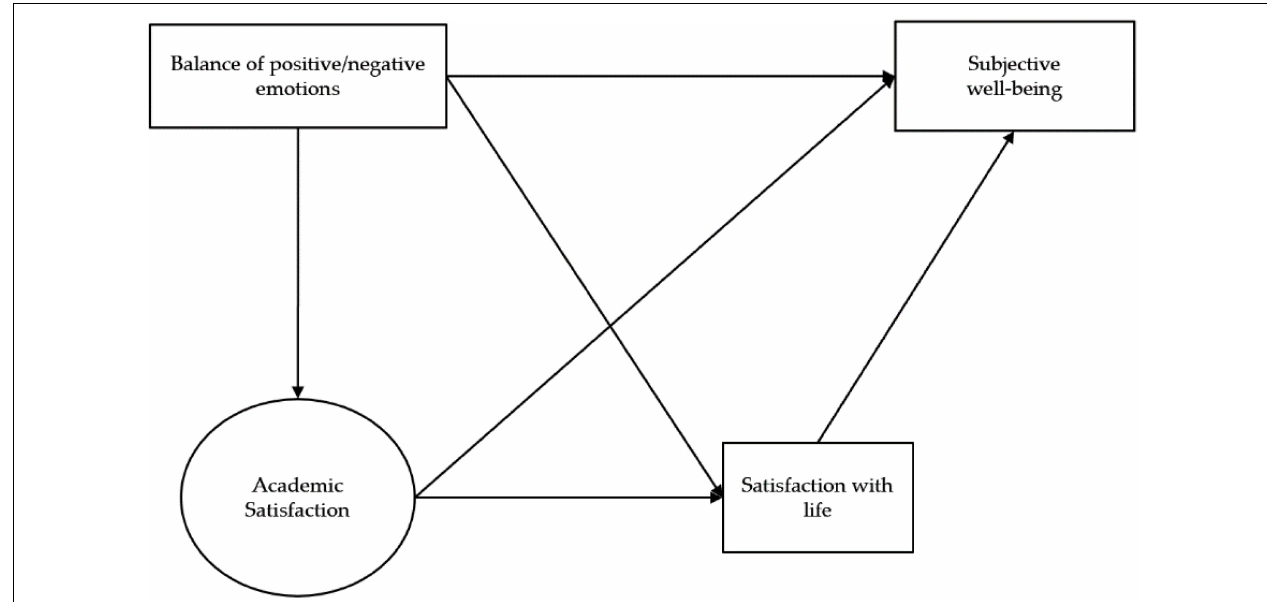
FIGURE 1 | Contribution of academic satisfaction on the subjective well-being